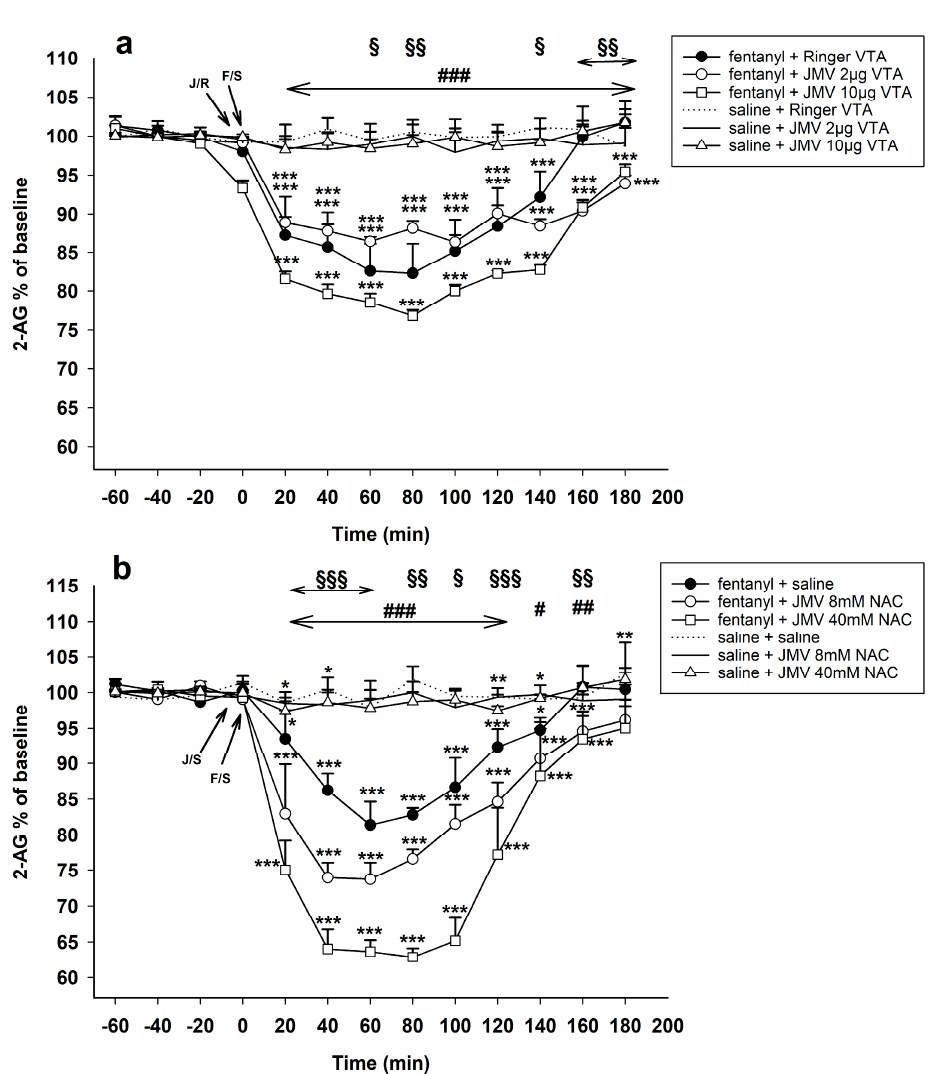
Figure 4. Effects of ghrelin receptor antagonist JMV2959 administered following four 20 min baselines into the VTA or into the NAC 5 min before fentanyl/saline on the accumbens 2-AG levels (means ± SEM). The effects are illustrated as follows: ( a ) Ringer’s solution/VTA + fentanyl (filled circle), 2 µg JMV2959/VTA + fentanyl (open circle), 10 µg JMV2959/VTA + fentanyl (open square), 2 µg JMV2959/VTA + saline (continuous line), 10 µg JMV2959/VTA + saline (open triangle), and Ringer’s solution + saline (dotting); and ( b ) saline + fentanyl (filled circle), JMV2959 lower dose 8 mM/15 min/NAC + fentanyl (open circle), JMV2959 higher dose 40 mM/15 min/NAC + fentanyl (open square), JMV2959 lower dose 8 mM/15 min/NAC + saline (continuous line), JMV2959 higher dose 40 mM/15 min/NAC + saline (open triangle), and Ringer’s solution + saline (dotting). Differences between treatments and the control group (Ringer’s/VTA + saline or saline + saline) are expressed as *** p < 0.001, ** p < 0.01, * p < 0.05. Differences between fentanyl and fentanyl in combinations with the higher JMV2959 dose (10 µg/VTA or 40 mM/15 min /NAC, respectively) are expressed as ### p < 0.001, ## p < 0.01, # p < 0.05. Differences between fentanyl and fentanyl in combinations with the lower JMV2959 dose (2 µg/VTA or 8 mM/15 min, respectively) are expressed as §§§ p < 0.001, §§ p < 0.01, § p < 0.05. The horizontal arrows show intervals with appropriate significant changes ( §§§ or §§ or ### ); the oblique arrows show the time of administration of J/S = JMV2959/saline or J/R = JMV2959/Ringer´s solution and F/S = fentanyl/saline.